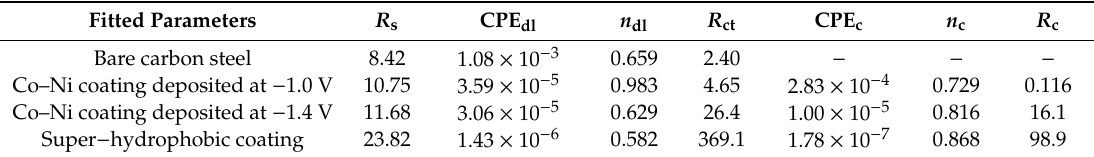
Table 4. The impedance parameters of bare carbon steel, Co–Ni coating deposited at − 1.0 and − 1.4 V, and super-hydrophobic Co–Ni coating deposited at − 1.7 V extracted by fitting the EIS results recorded in 3.5 wt.% NaCl solution (Figure 8) with the corresponding equivalent circuits. The units of R s , R ct , R c and CPE are Ω · cm 2 , k Ω · cm 2 , k Ω · cm 2 and Ω − 1 · s n · cm − 2 , respectively.